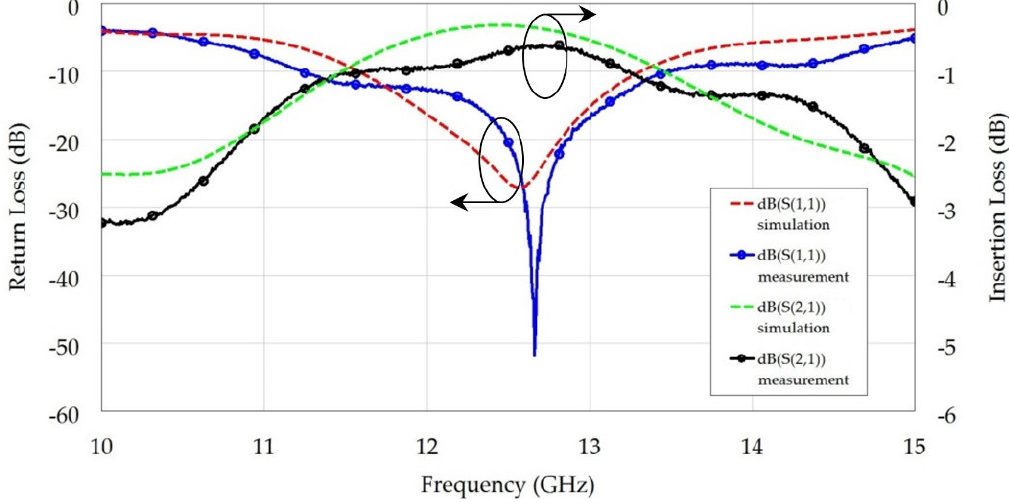
Figure 12. RWG-to-SIW transition scattering parameters for single-iris matching network.